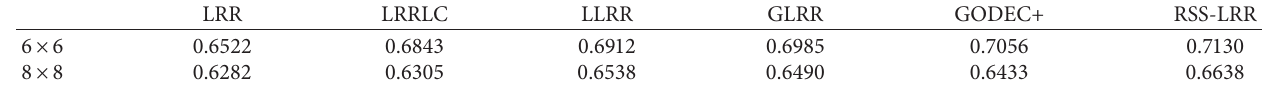
Table 7: Classification accuracies on COIL20 under 6 × 6 and 8 × 8 occlusions.